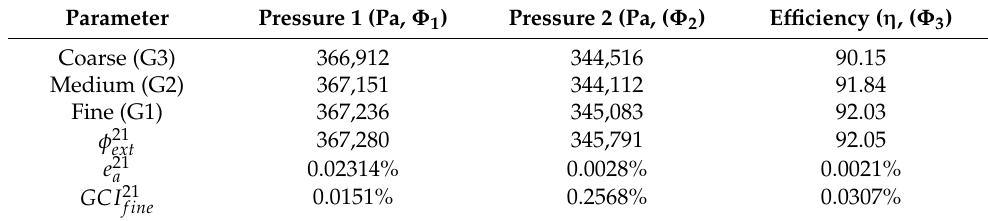
Table 2. Discretization error for the reference